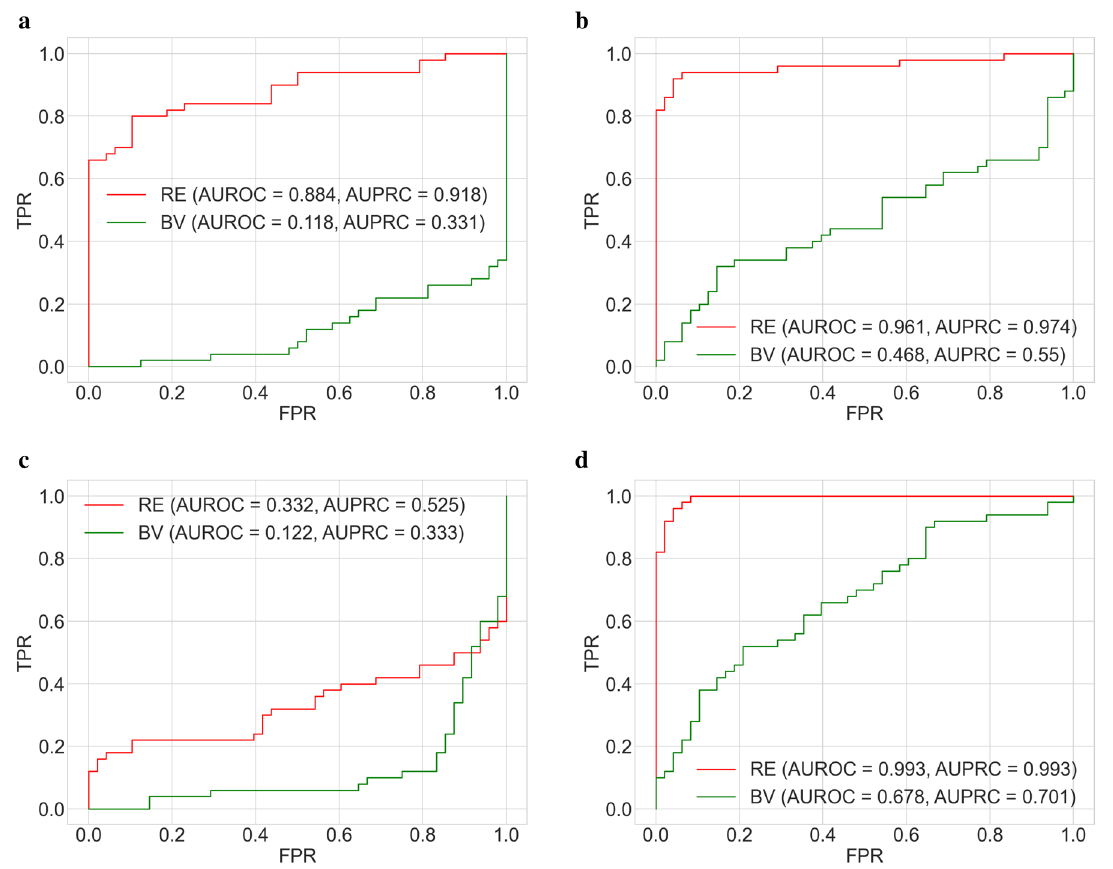
Fig. 11 ROC curves and AUROC, AUPRC scores for CARLA dataset (RE—the reconstruction error approach, BV—the bottleneck-values approach): a for model 1, b for model 2, c for model 3, d for model